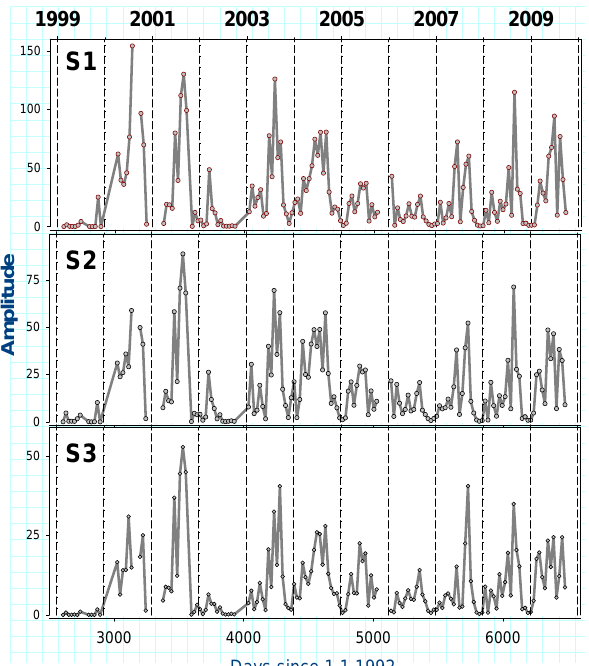
Figure 13: The temporal variation in the radon signal of the amplitudes of the daily periodic components S1, S2 and S3, is showing: a) concordance among the sensors of the Fig. 13. The temporal variation in the radon signal of the ampli- varying amplitudes and b) an annual modulation. tudes of the daily periodic components S1, S2 and S3, is showing: